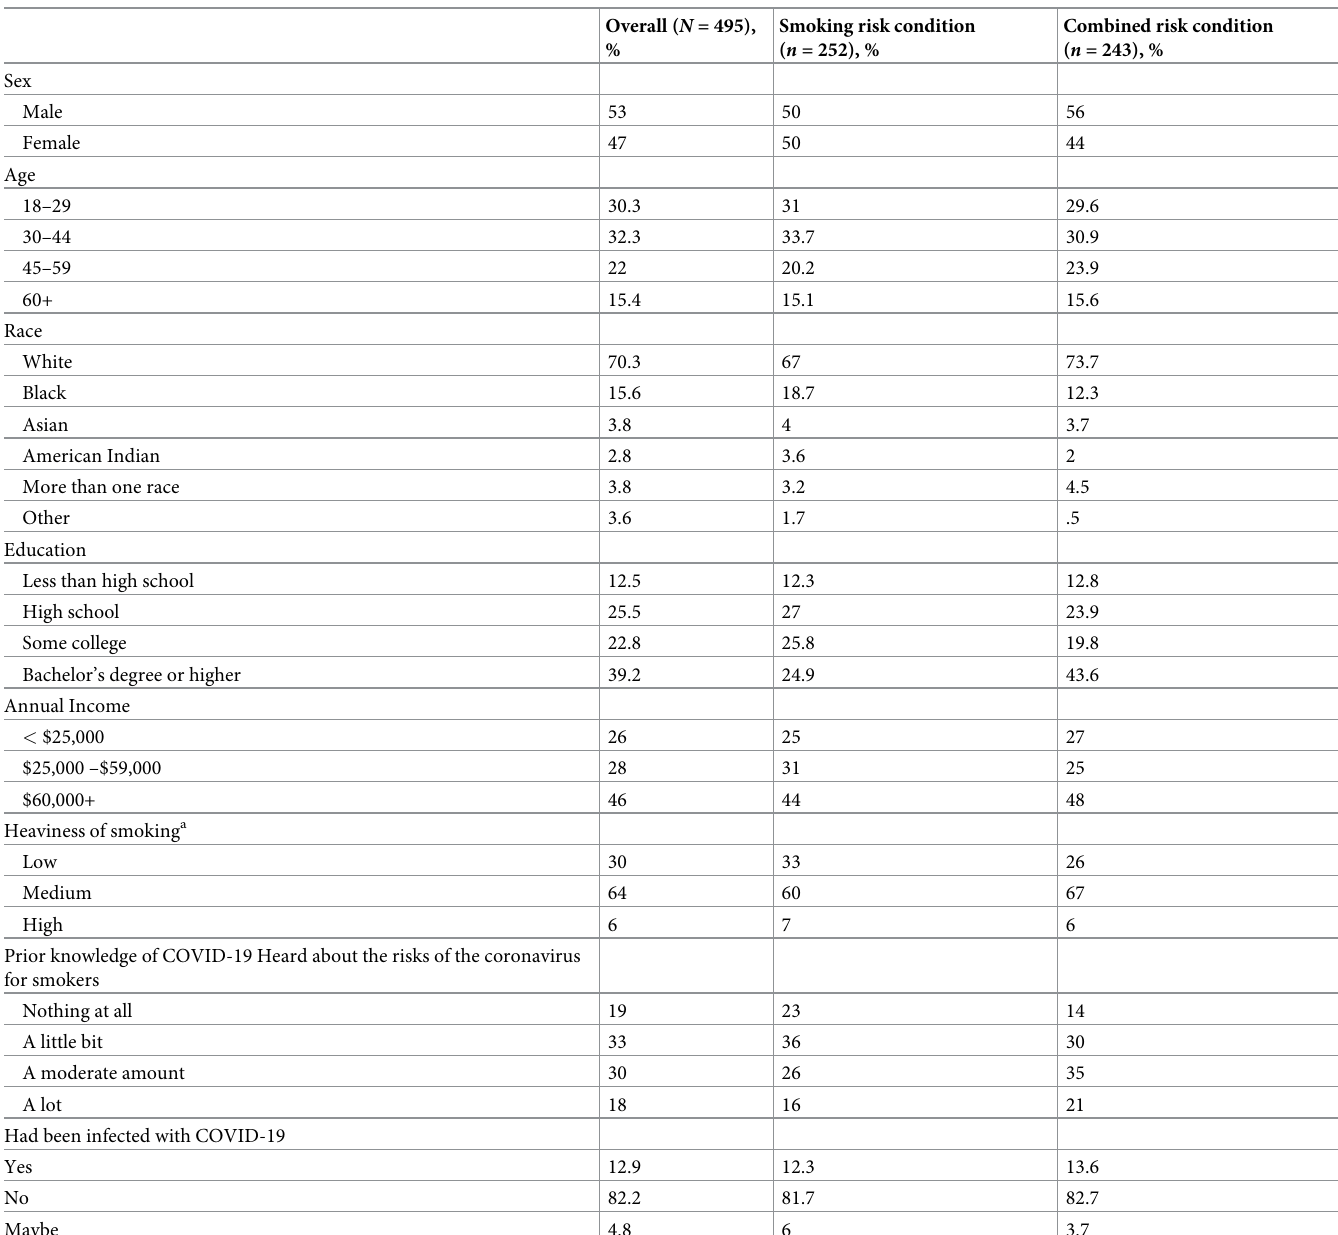
Table 1. Participants’ demographics.